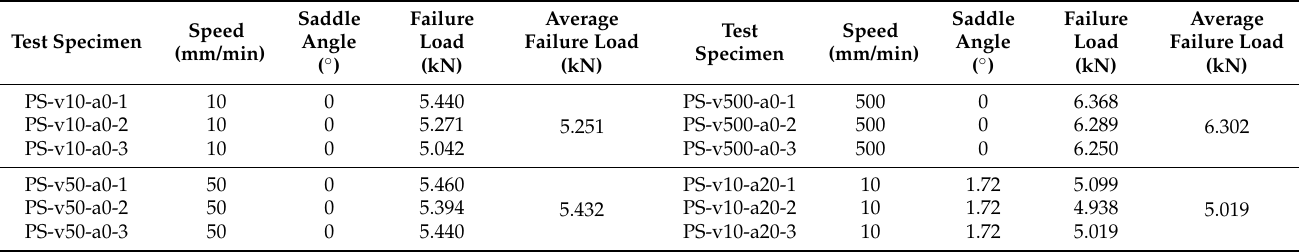
Table 2. Test results of lab-scale SSMR